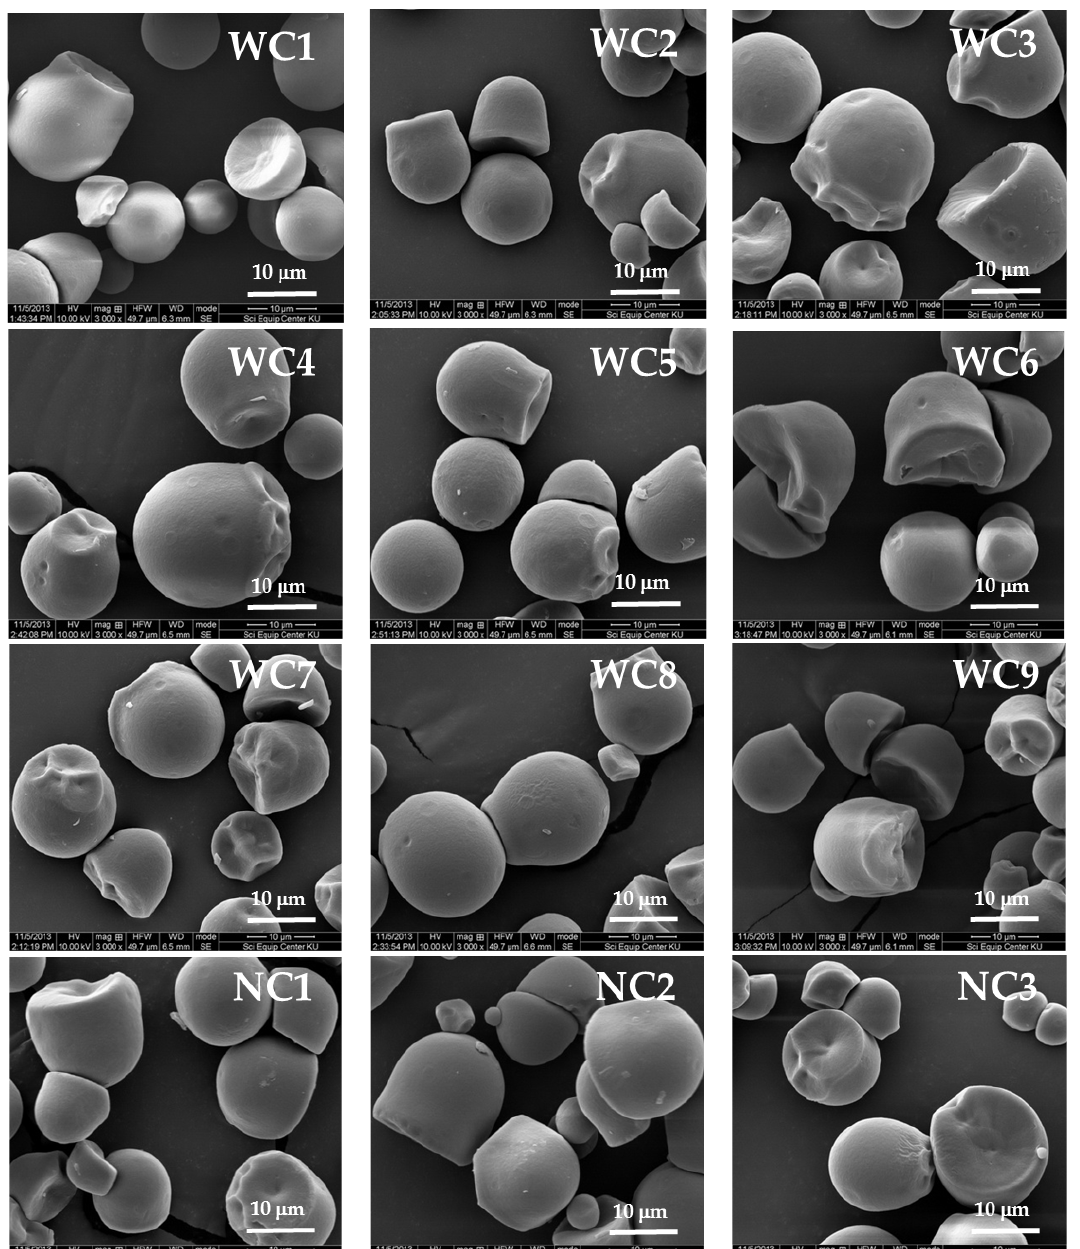
Figure 2. SEM photographs (x3000) of nine Thai non-GM bred waxy cassava starches (WC1–WC9) and three wild-type normal cassava starches (NC1–NC3).